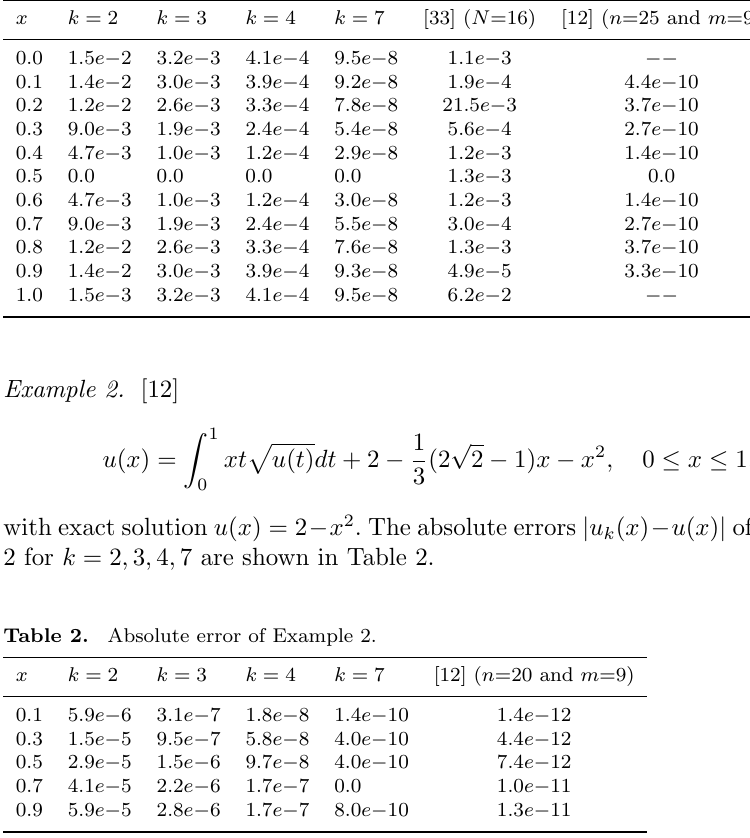
Table 1. Absolute error of Example 1.